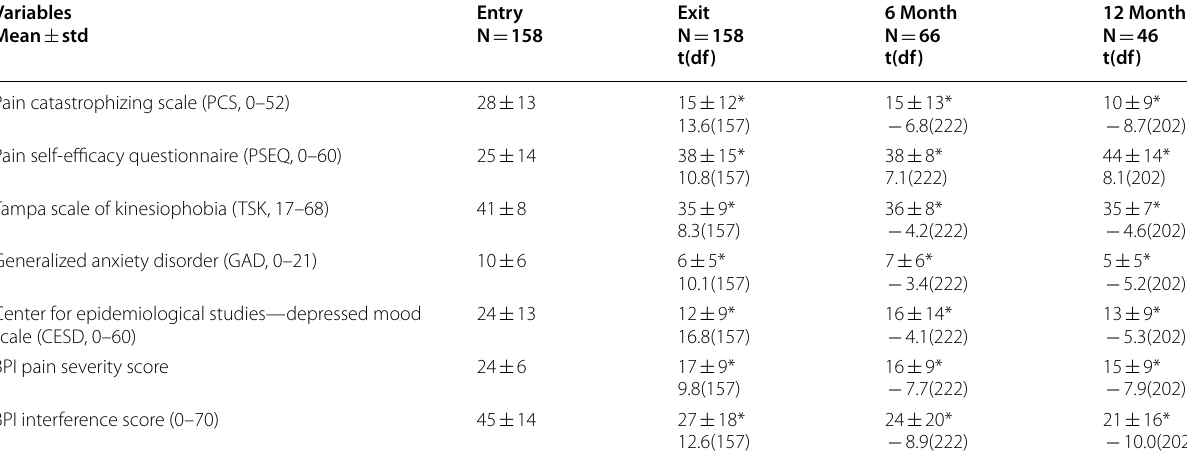
Statistical significance among group is marked by *. * p < 0.0001 level (2-tailed)